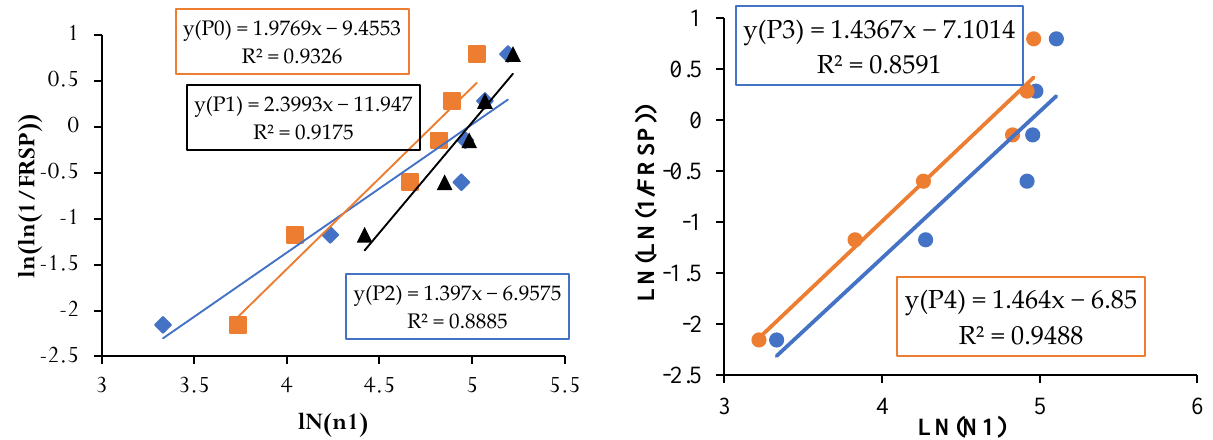
Figure 16. Weibull distribution for P0, P1, P2, P3 and P4 mixes at failure on 14 days. Figure 19. Weibull distribution for P0, P1, P2, P3 and P4 mixes at failure on 14 days.